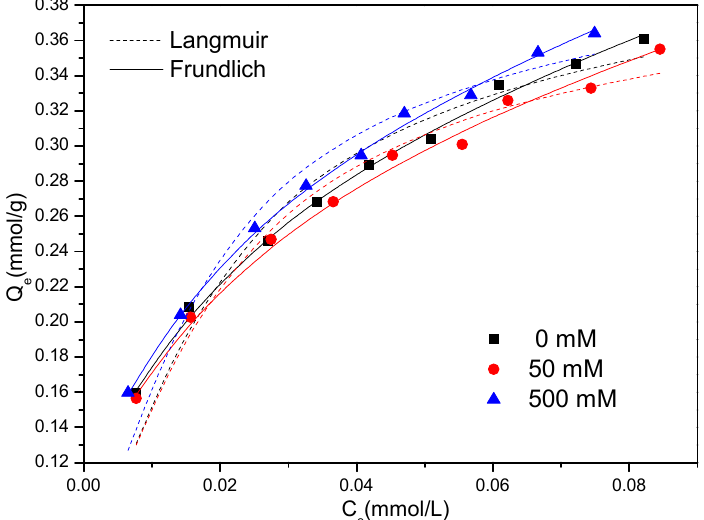
Figure 4. Adsorption isotherms of CAP for AC at three different ionic strengths fit by the Langmuir model (dashed lines) and Freundlich model (solid lines) (C 0 = 0.1–0.3 mmol/L, dosage = 30 mg/50 mL, temperature = 25 °C, pH = 6.20 ± 0.2, time = 24 h).